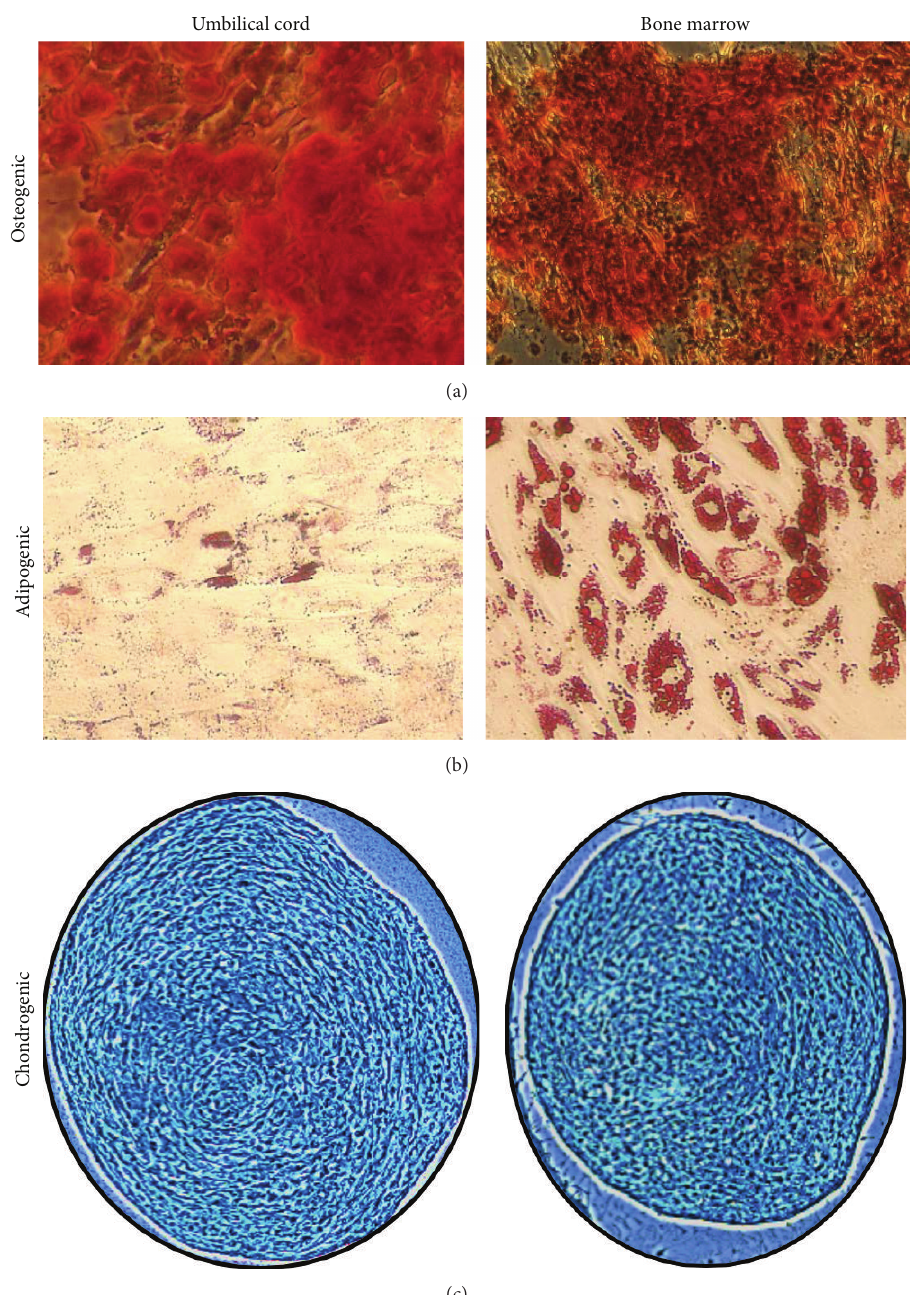
Figure 6: Umbilical cord MSCs exhibit trilineage differentiation potential. Representative images from passage 3 demonstrate (a) osteogenic differentiation using Alizarin Red staining, (b) adipogenic differentiation using Oil Red O, and (c) chondrogenic differentiation using Alcian Blue staining of chondrogenic pellets generated via micromass cultures. Bone marrow MSCs were used as positive control for demonstrating trilineage